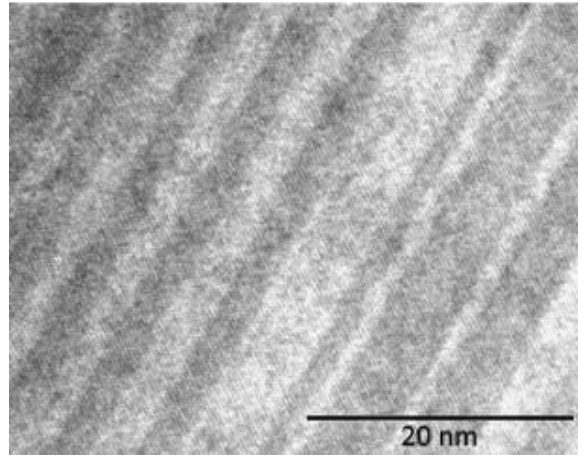
Figure 6. TEM bright-field image of QCL active region.